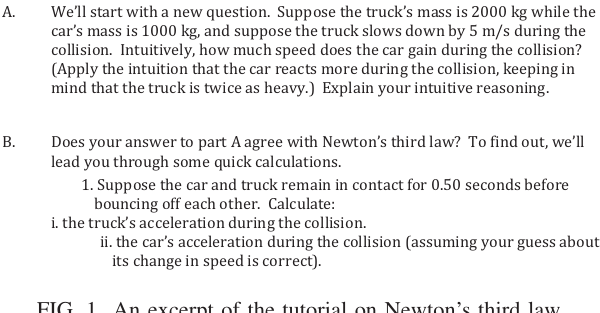
FIG. 1. An excerpt of the tutorial on Newton’s A. Critique of Alan: Interpreting Alan’s actions in terms of our values and beliefs 1. Episode 1: Alan constrains the conversation and fails to elicit student ideas